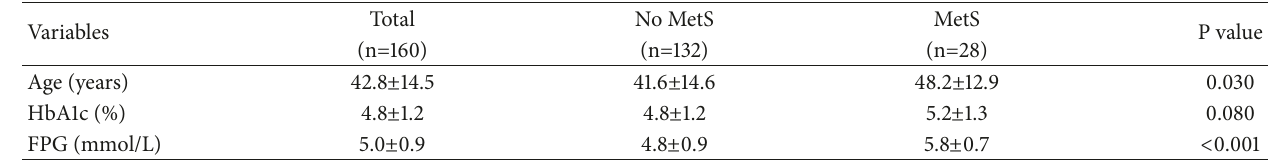
Table 1: Biochemical parameters of studied population stratified by MetS.